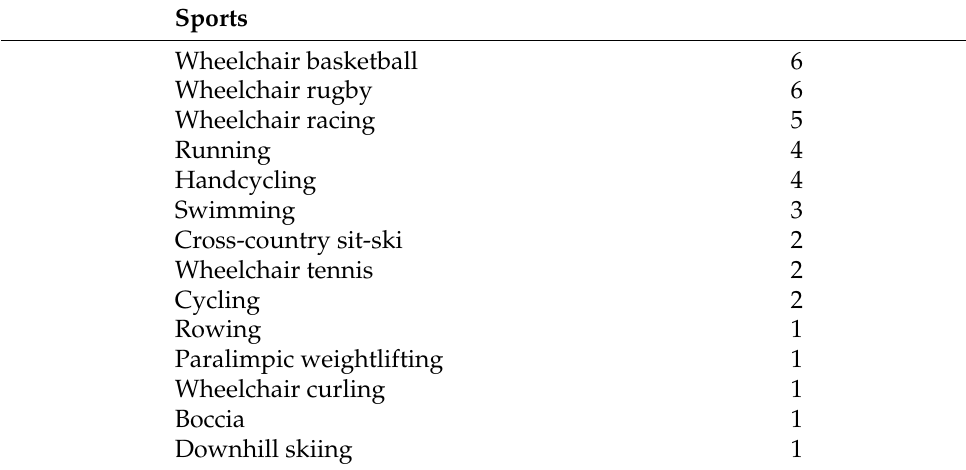
Table 2. Number of included papers per each investigated